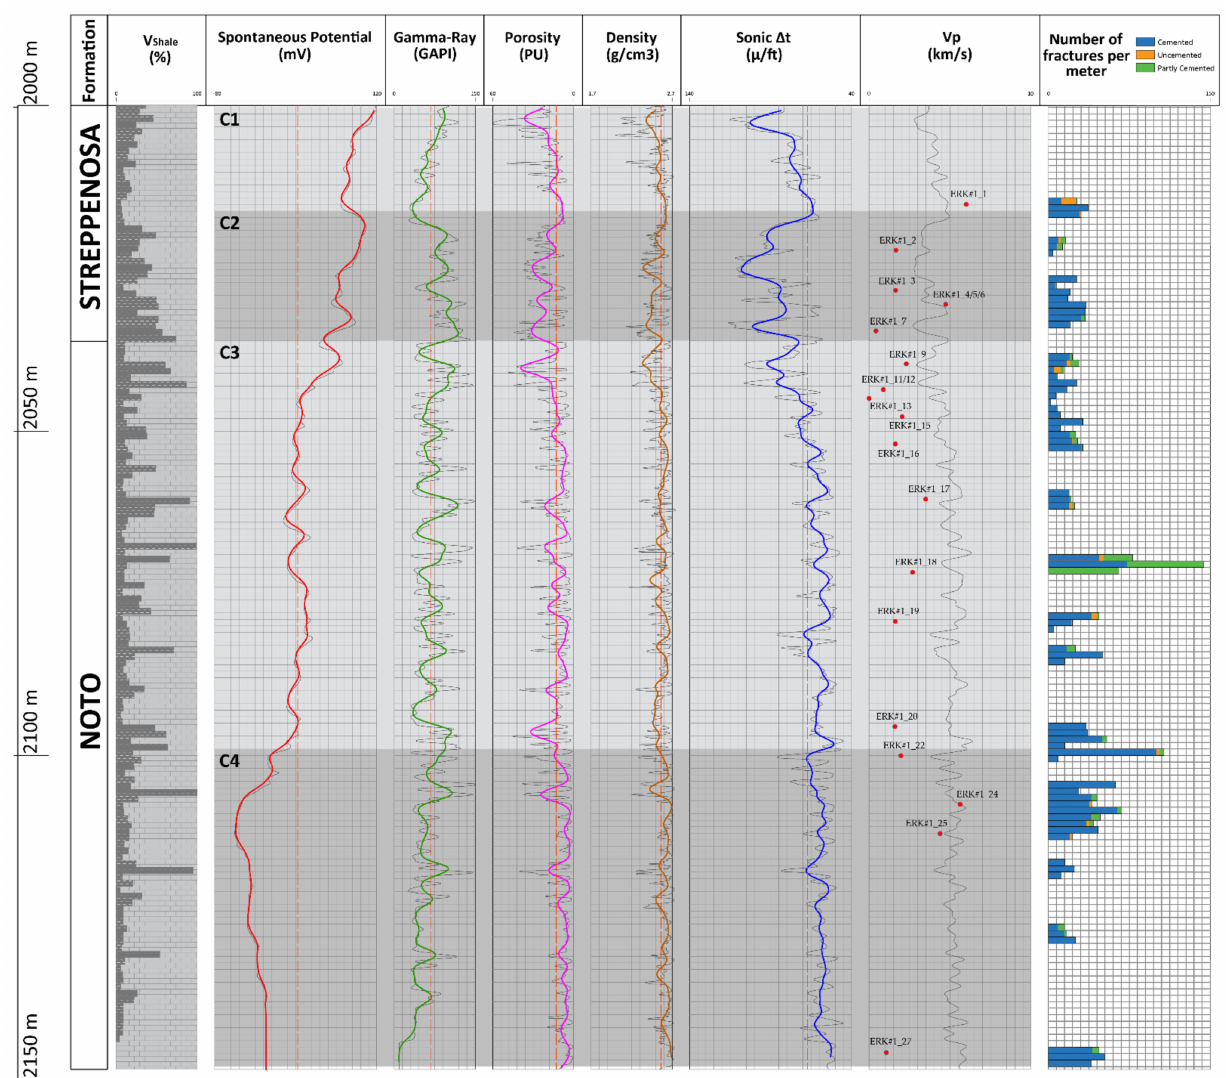
Figure 12. Evaluation log suite includes spontaneous potential, gamma ray, porosity, density, and sonic curves for the interval 2000–2148 m of the Eureka 1 well. The derived “Vp log” was also added and compared with the Vp values measured on 14 samples (red dots). Contextually to the counting of the fractures for some intervals of the Eureka 1 well, a qualitative estimate (cemented, uncemented, partly cemented) was carried